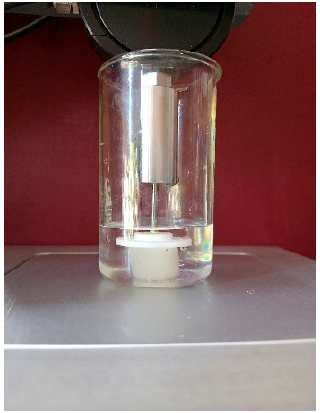
Figure 7. Spongy gelatin cryostructurate uniaxially compressed with a plate ‐ like punch connected to a TA ‐ Plus texture analyzer.